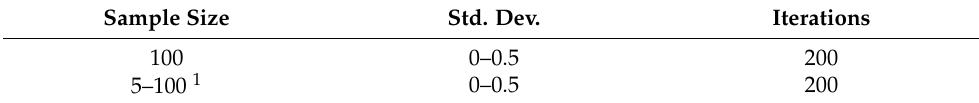
Figure 4. Effect on the parameter U M ( P , σ ) of different sample sizes for normal perturbation terms with standard deviations from 0 to 0.5: ( a ) P = 5; ( b ) P = 10; ( c ) P = 20; ( d ) P = 50; ( e ) P = 70; ( f ) P = 100. Table 1. Model parameters for the Example 1.